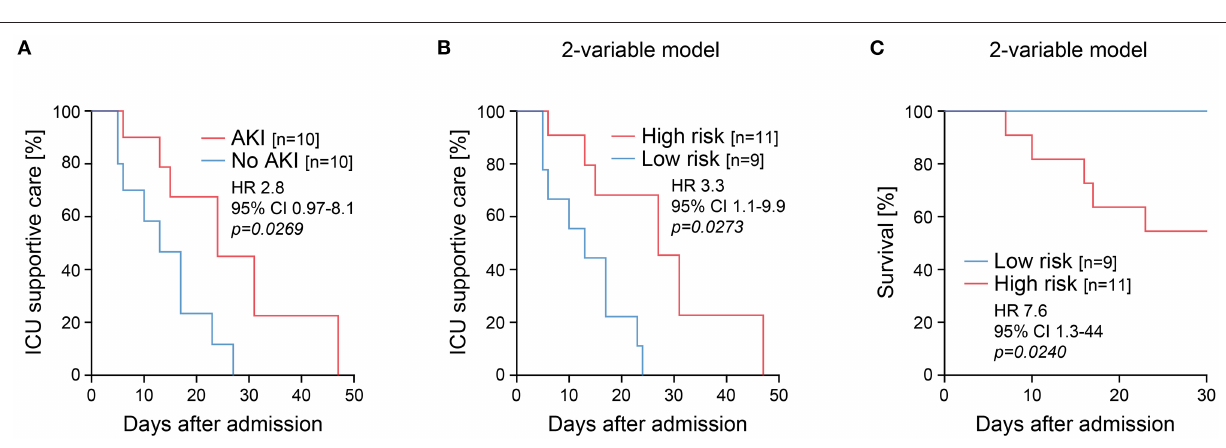
FIGURE 4 | Combining urinary SARS-CoV-2N and plasma albumin measurements associates with length of ICU supportive care and premature death in COVID-19. (A) Duration of ICU supportive care grouped for AKI. (B) Duration of ICU supportive care grouped for established two-variable model. (C) Premature death in COVID-19 grouped for established two-variable model. AKI, acute kidney injury; CI, confidence interval; HR, hazard ratio; ICU, intensive care